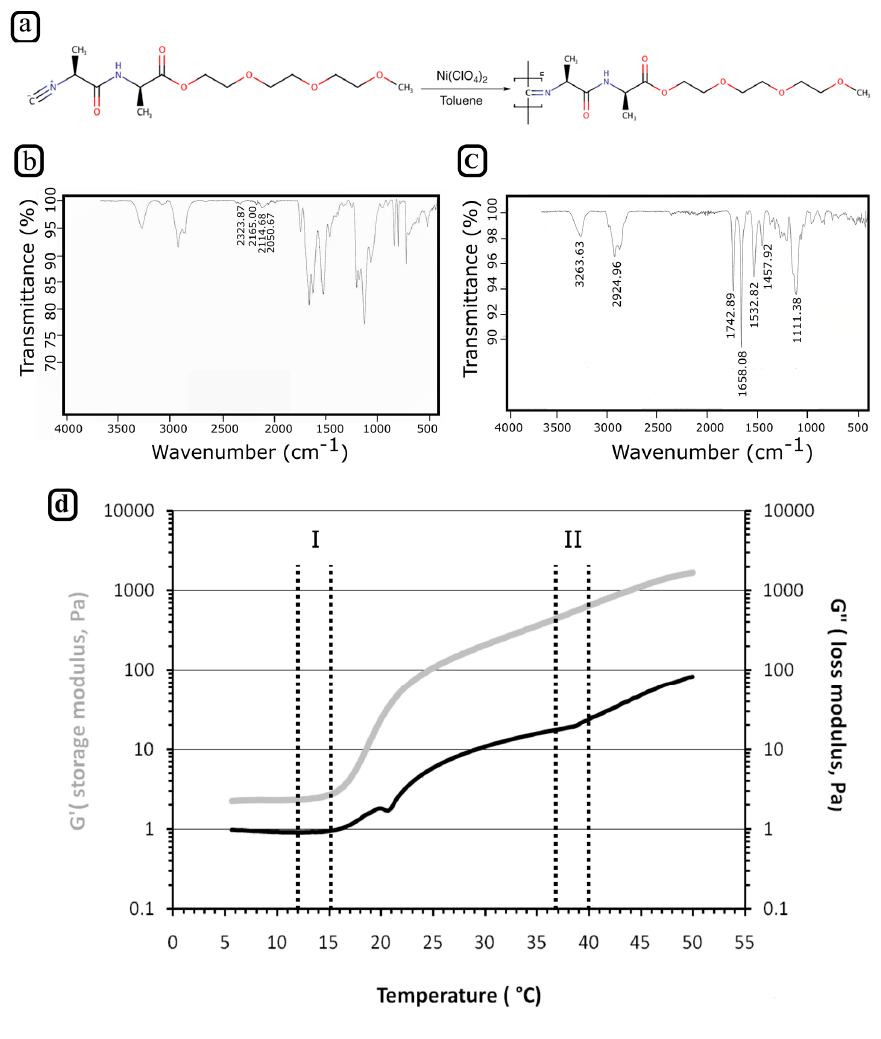
Figure 1. Synthesis of PIC polymer and rheological characterization of PIC hydrogels. ( a ) Chemical structure of PIC polymer, ( b ) IR-spectra of the reaction mixture, ( c ) IR-spectra of the resulting PIC polymer ( d ) Rheological data representing the loss and storage modulus as a function of temperature for 5 mg/mL PIC hydrogel solution. Dotted lines show (respectively) the ranges of (I) the cartridge temperature and (II) the printing bed temperature used in our experiments.